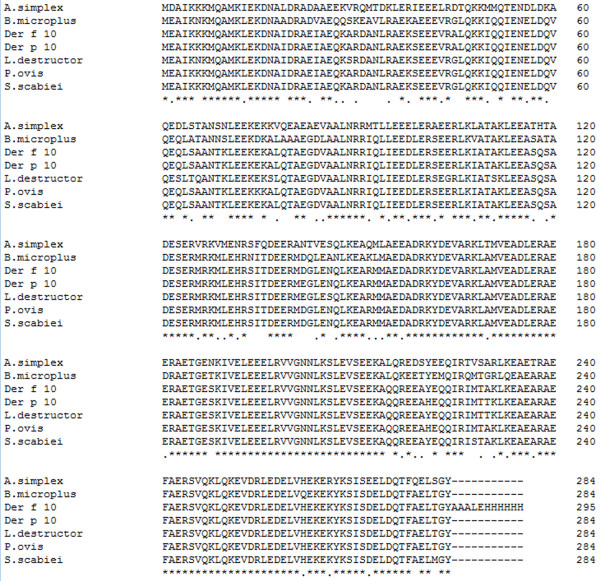
Comparison of SsTm with the tropomyosin amino acid sequences of other species. Genebank accession numbers: A. simplex, CAB93501; B. microplus, AAD17324; Der f 10, BAA04557; Der p 10, CAJ44440; L. destructor, CAB71342; P. ovis, CAJ38272; S. scabiei, JF922117.